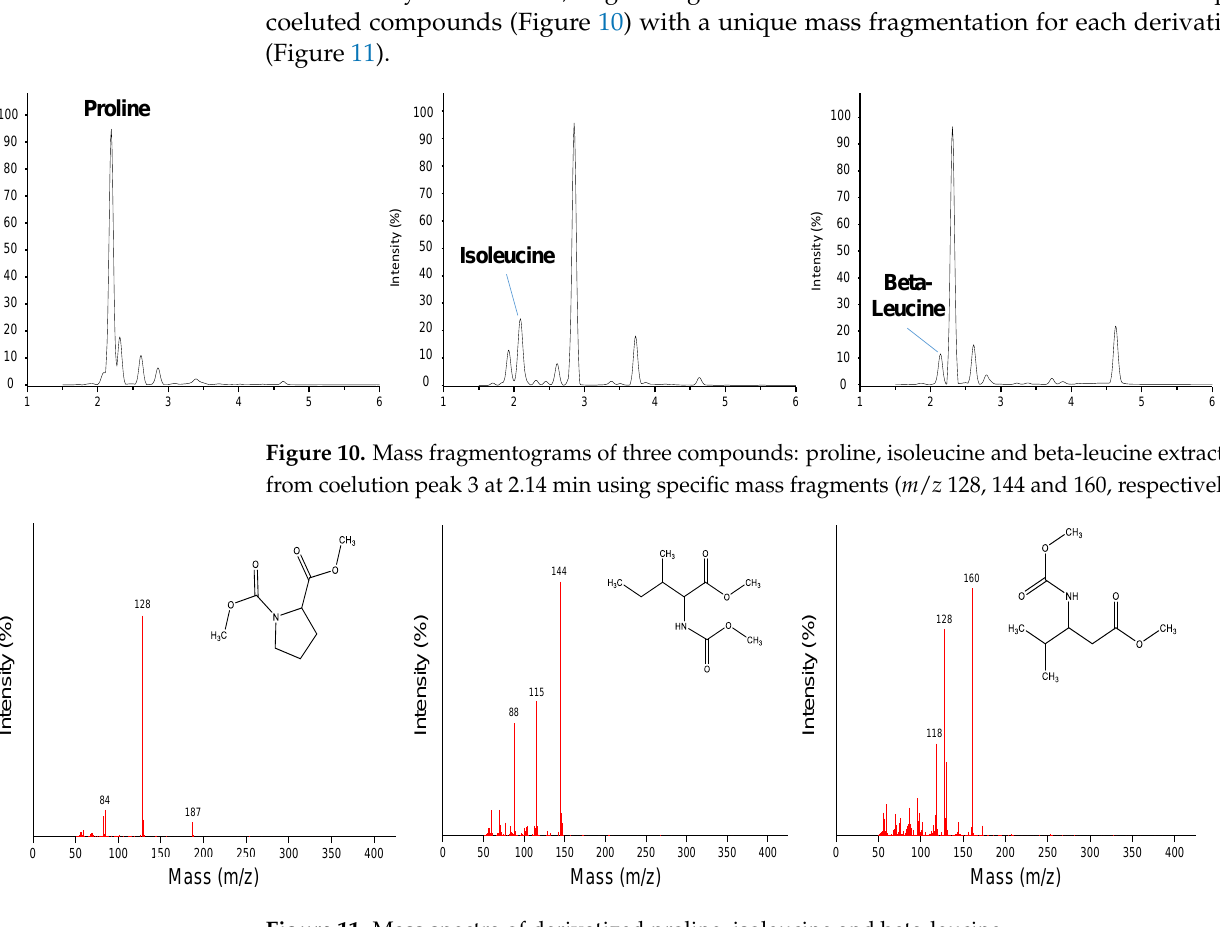
Figure 11. Mass spectra of derivatized proline, isoleucine and beta-leucine.